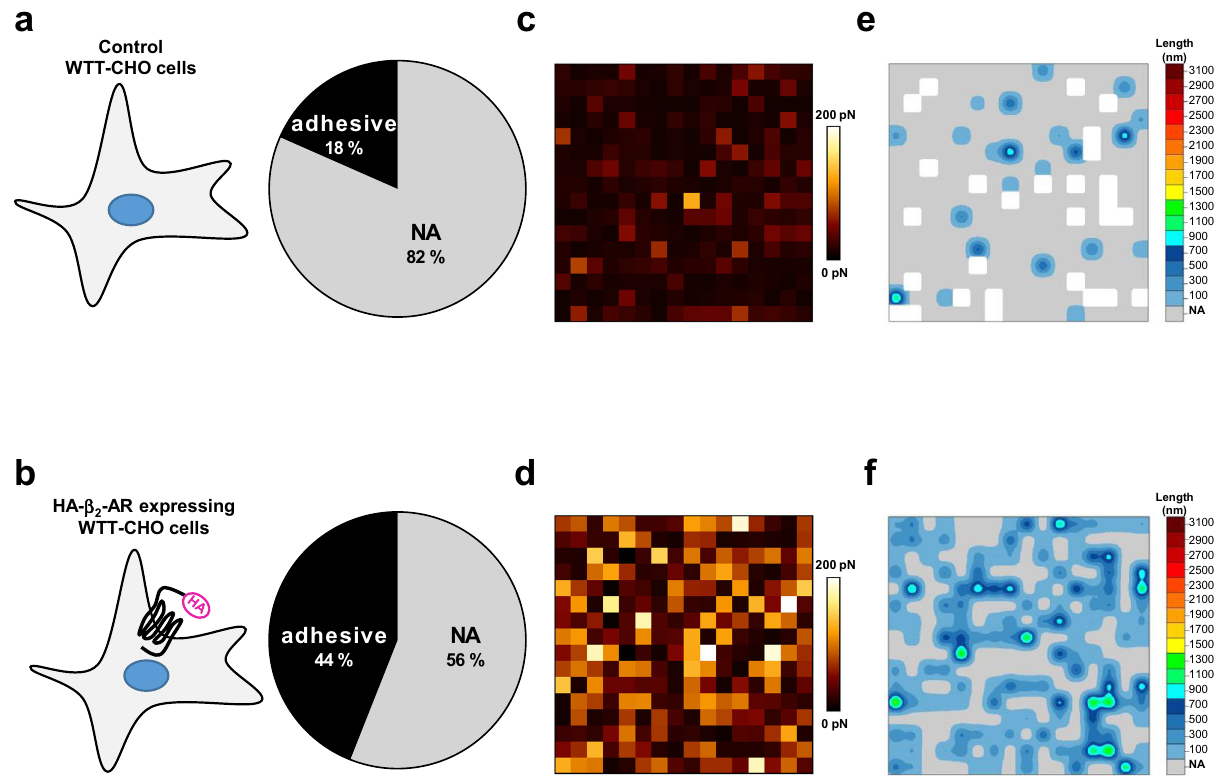
Fig. 3 Force-distance recorded by SMFS in HA-GPCR-non-expressing and expressing WTT-CHO cells. SMFS experiments using the anti-HA- functionalized AFM tip were conducted on WTT-CHO cells transiently transfected with ( a , c , e ) the empty vector as a negative control of speci fi city for HA-GPCR detection or ( b , d , f ) with 1 µ g of HA- β 2- AR-encoding vector (HA- β 2 -AR High ). a , b The proportions of adhesive and non-adhesive (NA) events detected in the SMFS experiments are shown in the pie charts. c , d Adhesion forces and ( e , f ) unfolding distances resulting from SMFS performed on one representative cell area (3 × 3 µ m 2 ) were depicted as a spatial map. At least nine cells from three independent experiments were